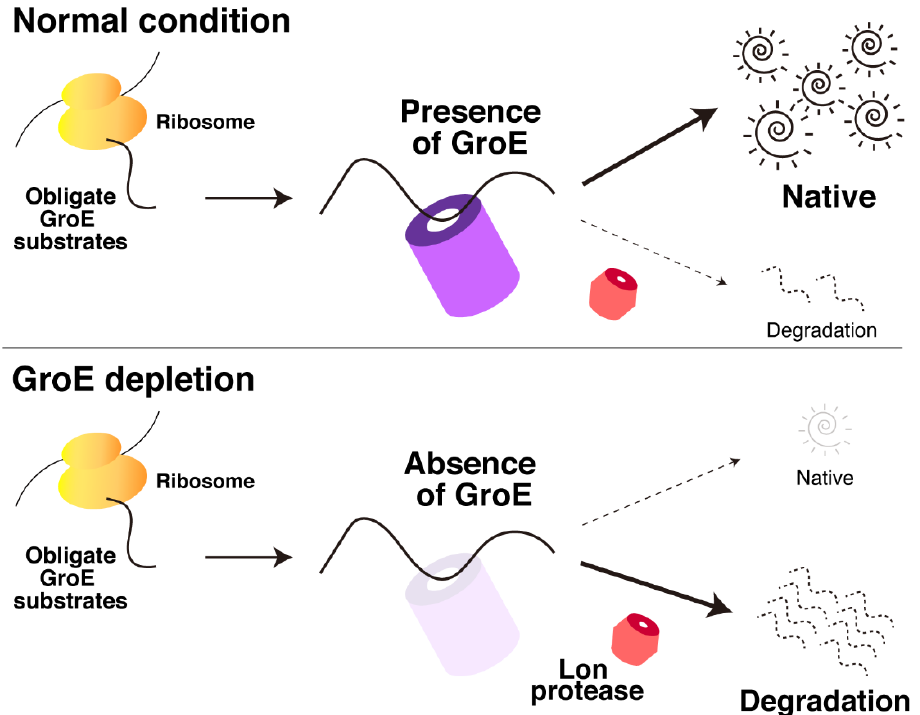
Figure 4. Schematic illustration of the fate of in vivo obligate GroE substrates in GroE-depleted cells. Under normal conditions, the in vivo obligate GroE substrates can fold into their native structures with the aid of GroE. Upon GroE depletion, these GroE substrates tend to be degraded by proteases, preferentially by the Lon protease, since they cannot complete their folding without GroE.